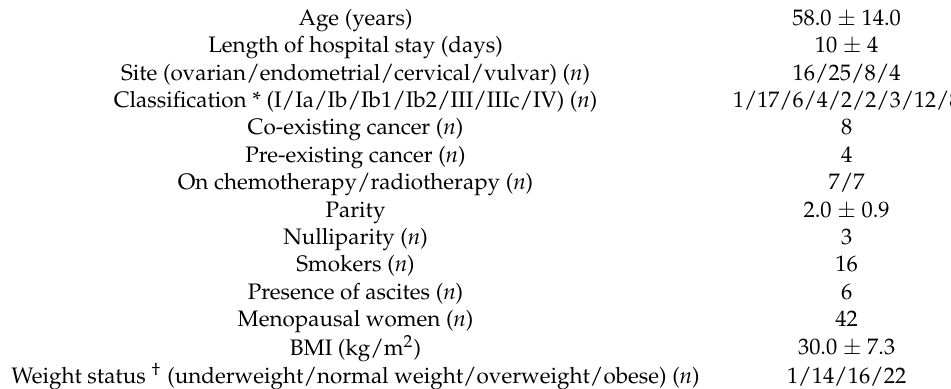
Table 1. Patient characteristics at baseline ( n , or mean ± SD) (N =